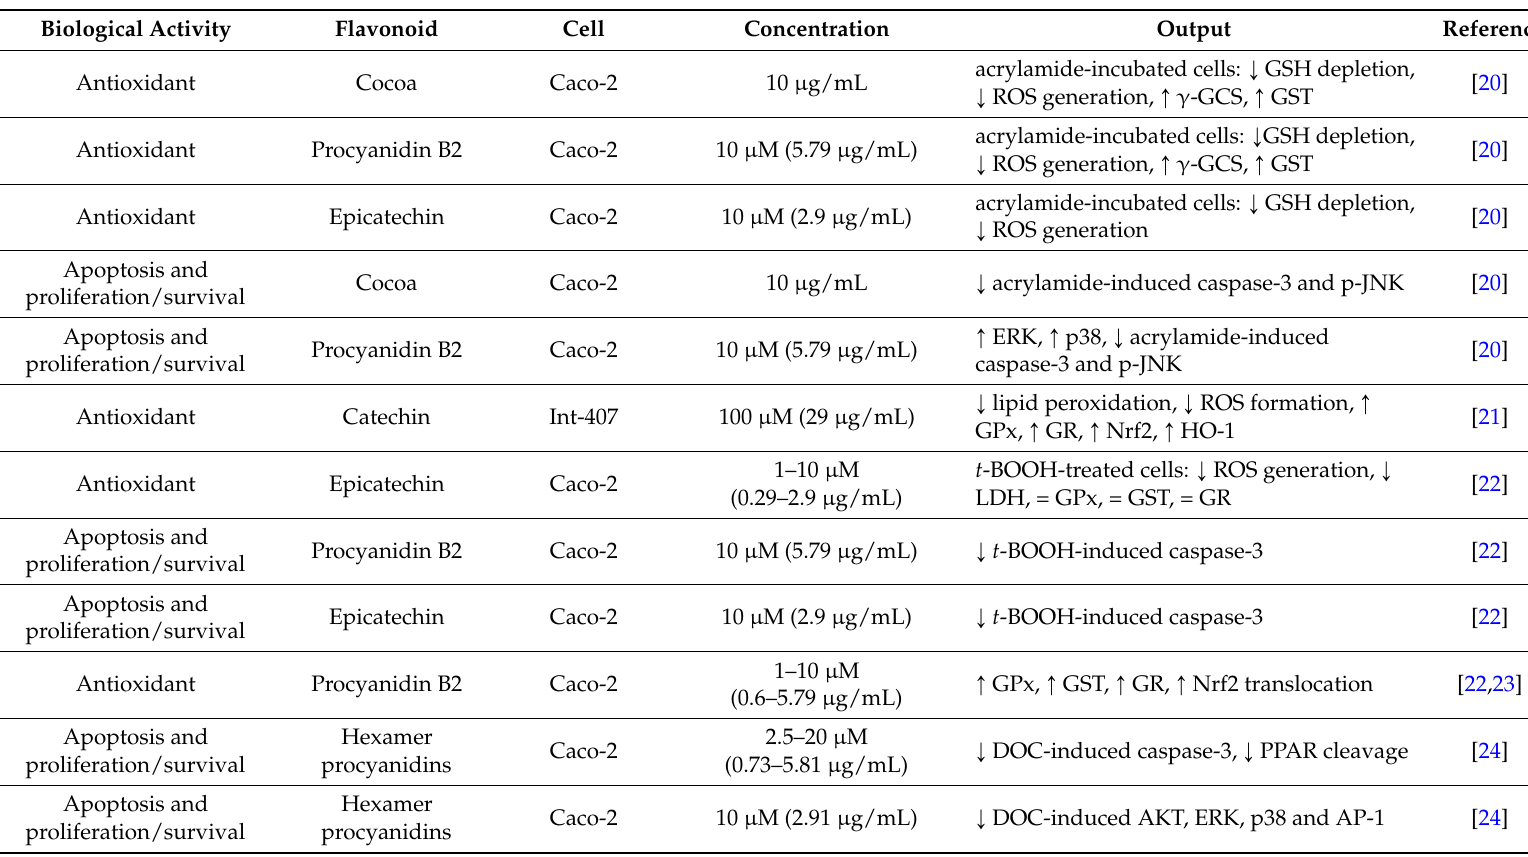
Table 1. Effects of cocoa and cocoa flavonoids on colonic cancer cultured cell lines a . The arrow indicates an increase ( Ò ) or decrease ( Ó ) in the levels or activity of the different analyzed parameters, and “=” designates an unmodified parameter. DOC, deoxycholic